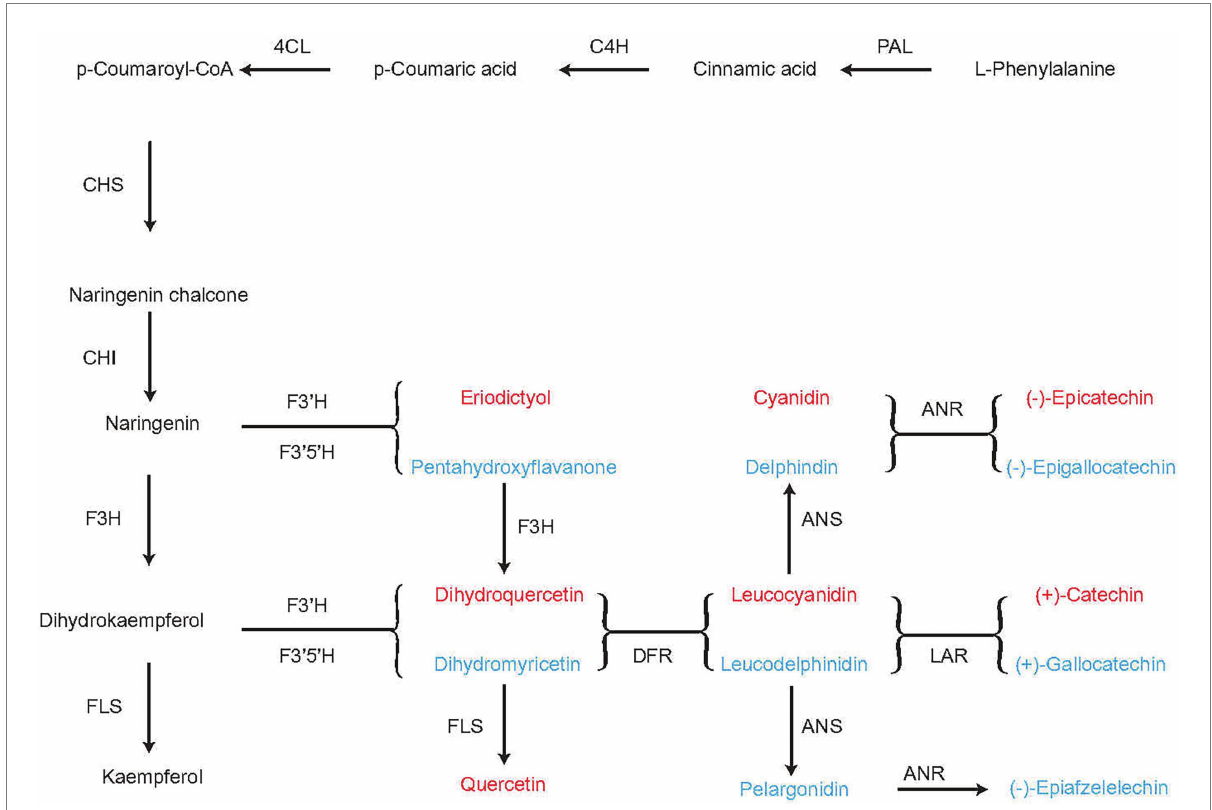
FIGURE 7 Flavonoid biosynthesis pathway in the tea plant. PAL, phenylalanine ammonia lyase; C4H: cinnamate 4-hydroxylase; 4CL: 4-coumarate-CoA ligase; CHS, chalcone synthase; CHI, chalcone isomerase; F3H, flavanone 3-hydroxylase; DFR, dihydroflavonol 4-reductase; ANR, anthocyanidin reductase; F3 ′ 5 ′ H, flavonoid-3 ′ 5 ′ -hydroxylase; F3’H, flavonoid 3 ′ -hydroxylase; FLS, flavonol synthase; LAR, leucoanthocyanidin